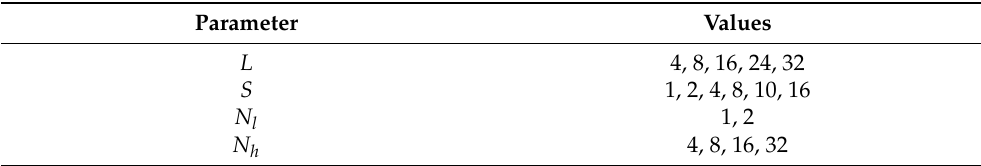
Table 1. Values of hyperparameters used for testing the variants of LSTM networks and input signal